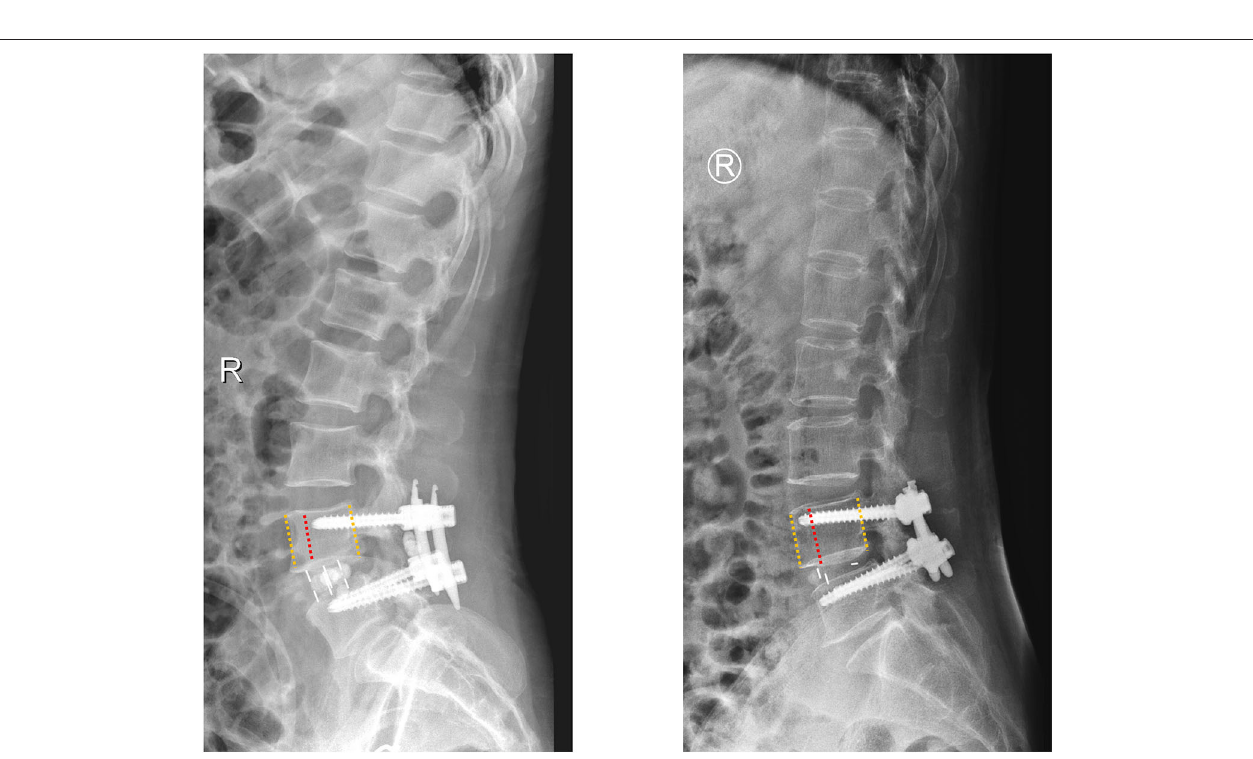
FIGURE 2 | A schematic diagram of insertion depth; the patients were assigned to the S group (the screws accounted for 60–80% of the anteroposterior diameter of vertebral body) and the L group (the screws accounted for more than 80% of the anteroposterior diameter of vertebral body).